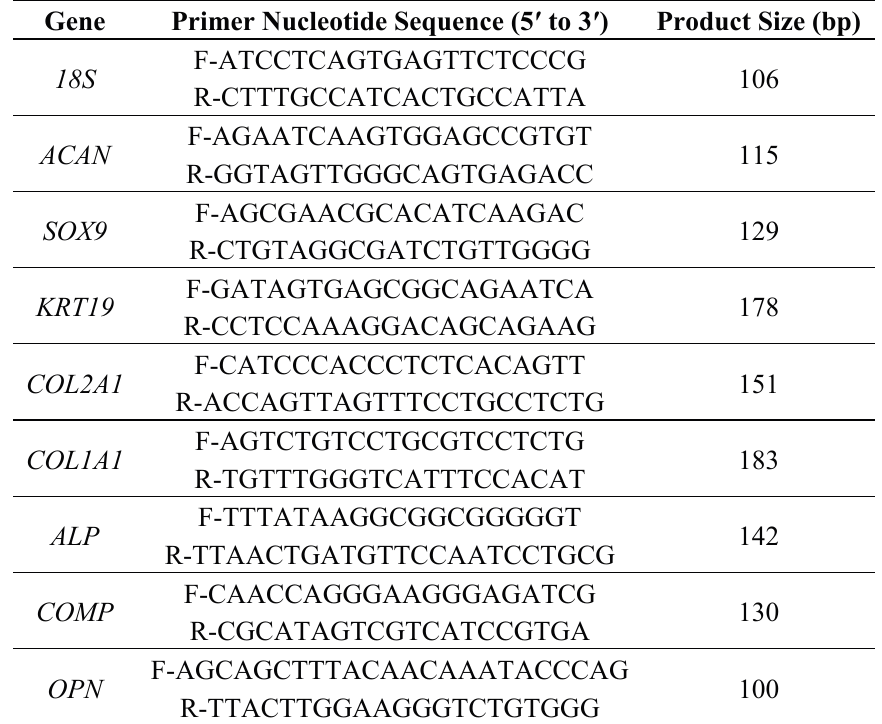
Table 1. Primers used in quantitative RT-PCR. (F = Forward, R =